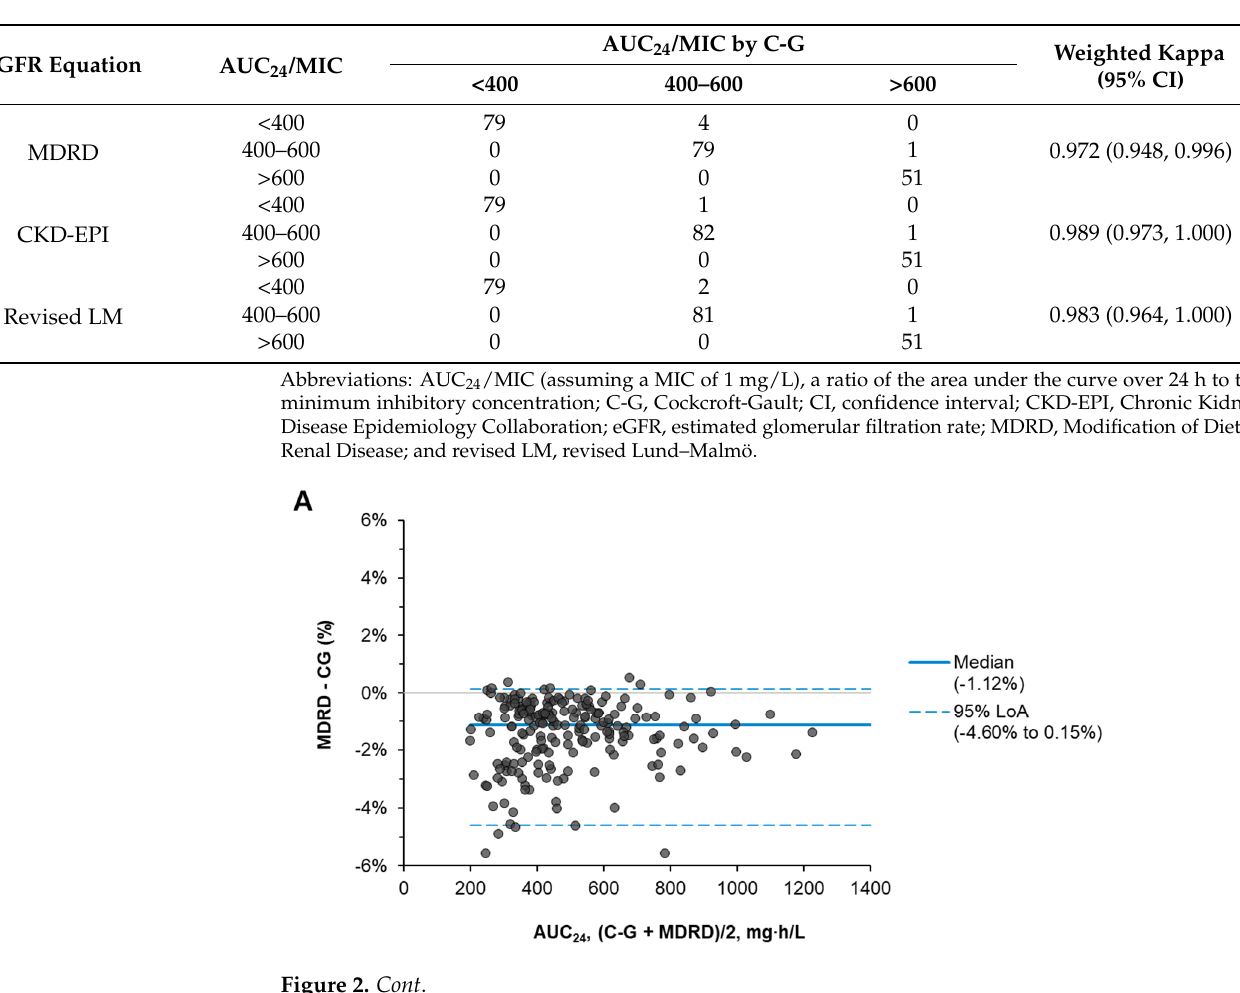
Figure 2. Bland–Altman plots for AUC 24 of vancomycin according to the estimated glomerular fil- tration rate equations. ( A ) Between C-G and MDRD. ( B ) Between C-G and CKD-EPI. ( C ) Between C-G and the revised LM. Outliers were excluded (( A ), n = 2; ( B ), n = 2; and ( C ), n = 3). See Appendix A (Figure A1) for all data results, including outliers. Abbreviations: AUC, area under the curve over 24 h; C-G, Cockcroft-Gault; CKD-EPI, Chronic Kidney Disease Epidemiology Collaboration; MDRD, Modification of Diet in Renal Disease; LoA, limit of agreement; and LM, Lund–Malmö.